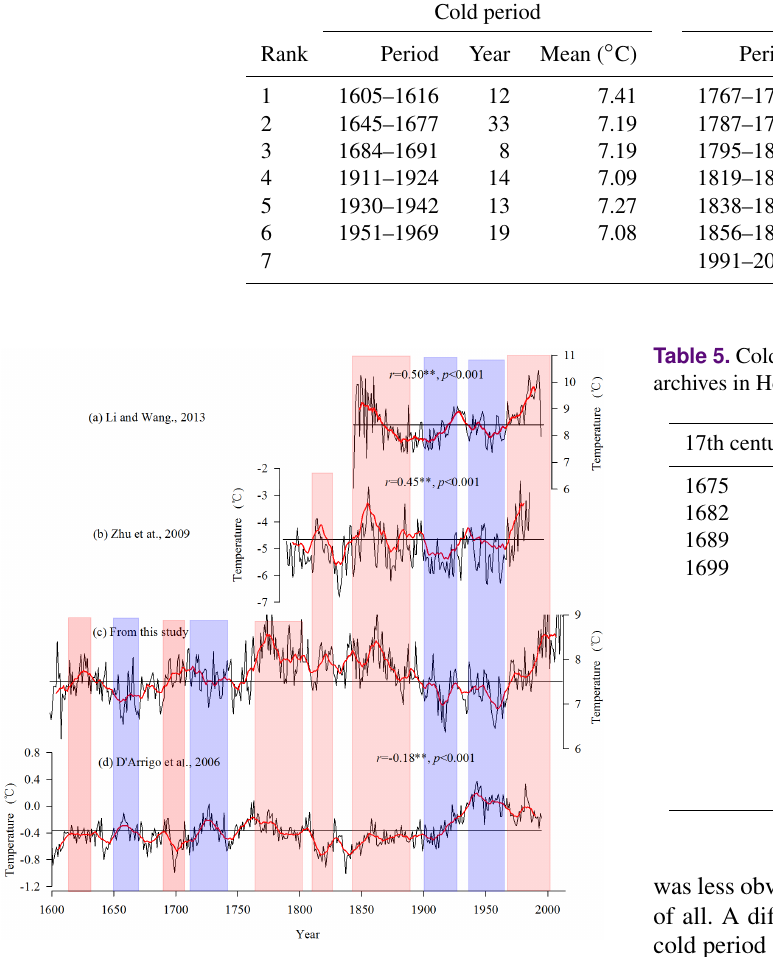
Figure 7. (a) April–September mean minimum temperature recon- structed by Li and Wang (2013) in Dunhua, (b) February–April temperature established by Zhu et al. (2009) on Changbai Moun- tain, (c) April–July minimum temperature on Laobai Mountain, and (d) Northern Hemisphere extratropical temperature (D’Arrigo et al., 2006). Black lines denote temperature reconstruction values, and red color lines indicate the 11-year moving average.